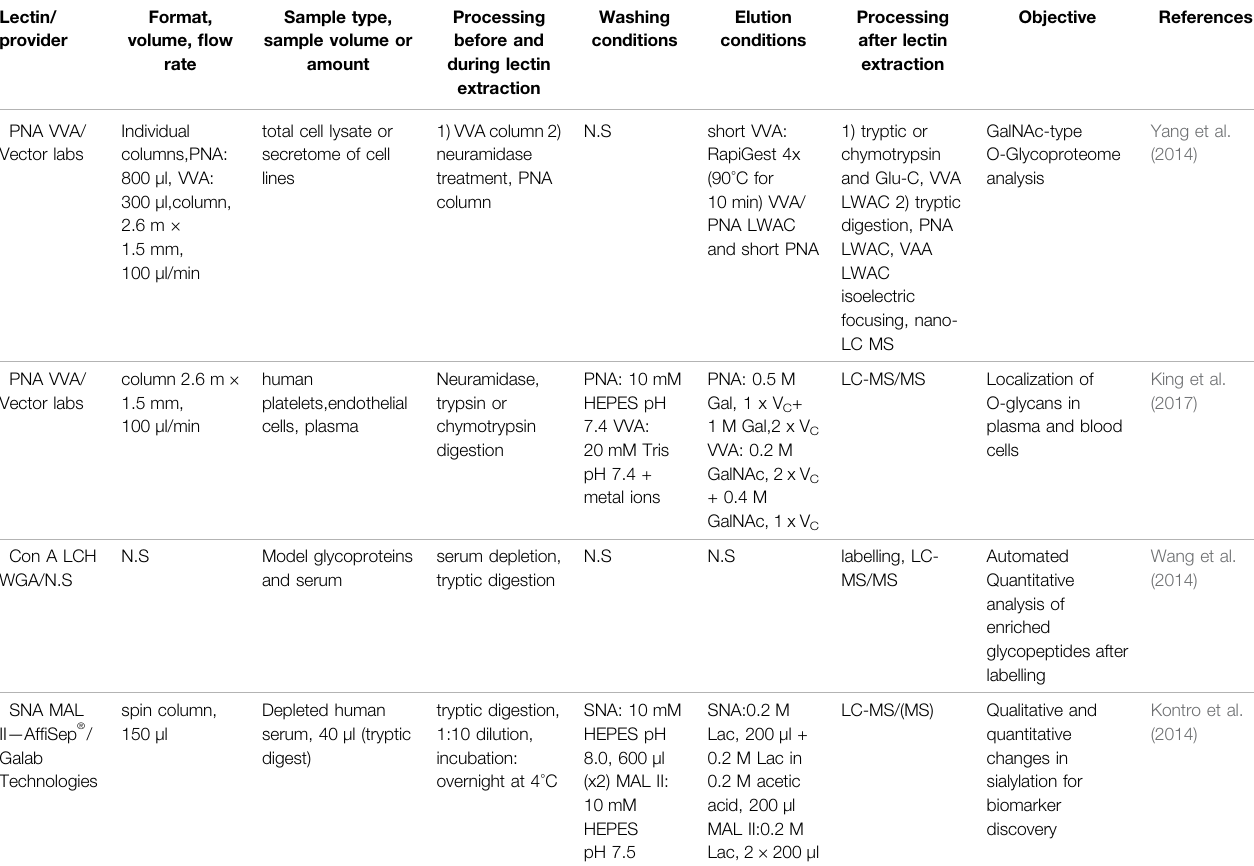
Figure 1A. The usual experimental protocol of lectin